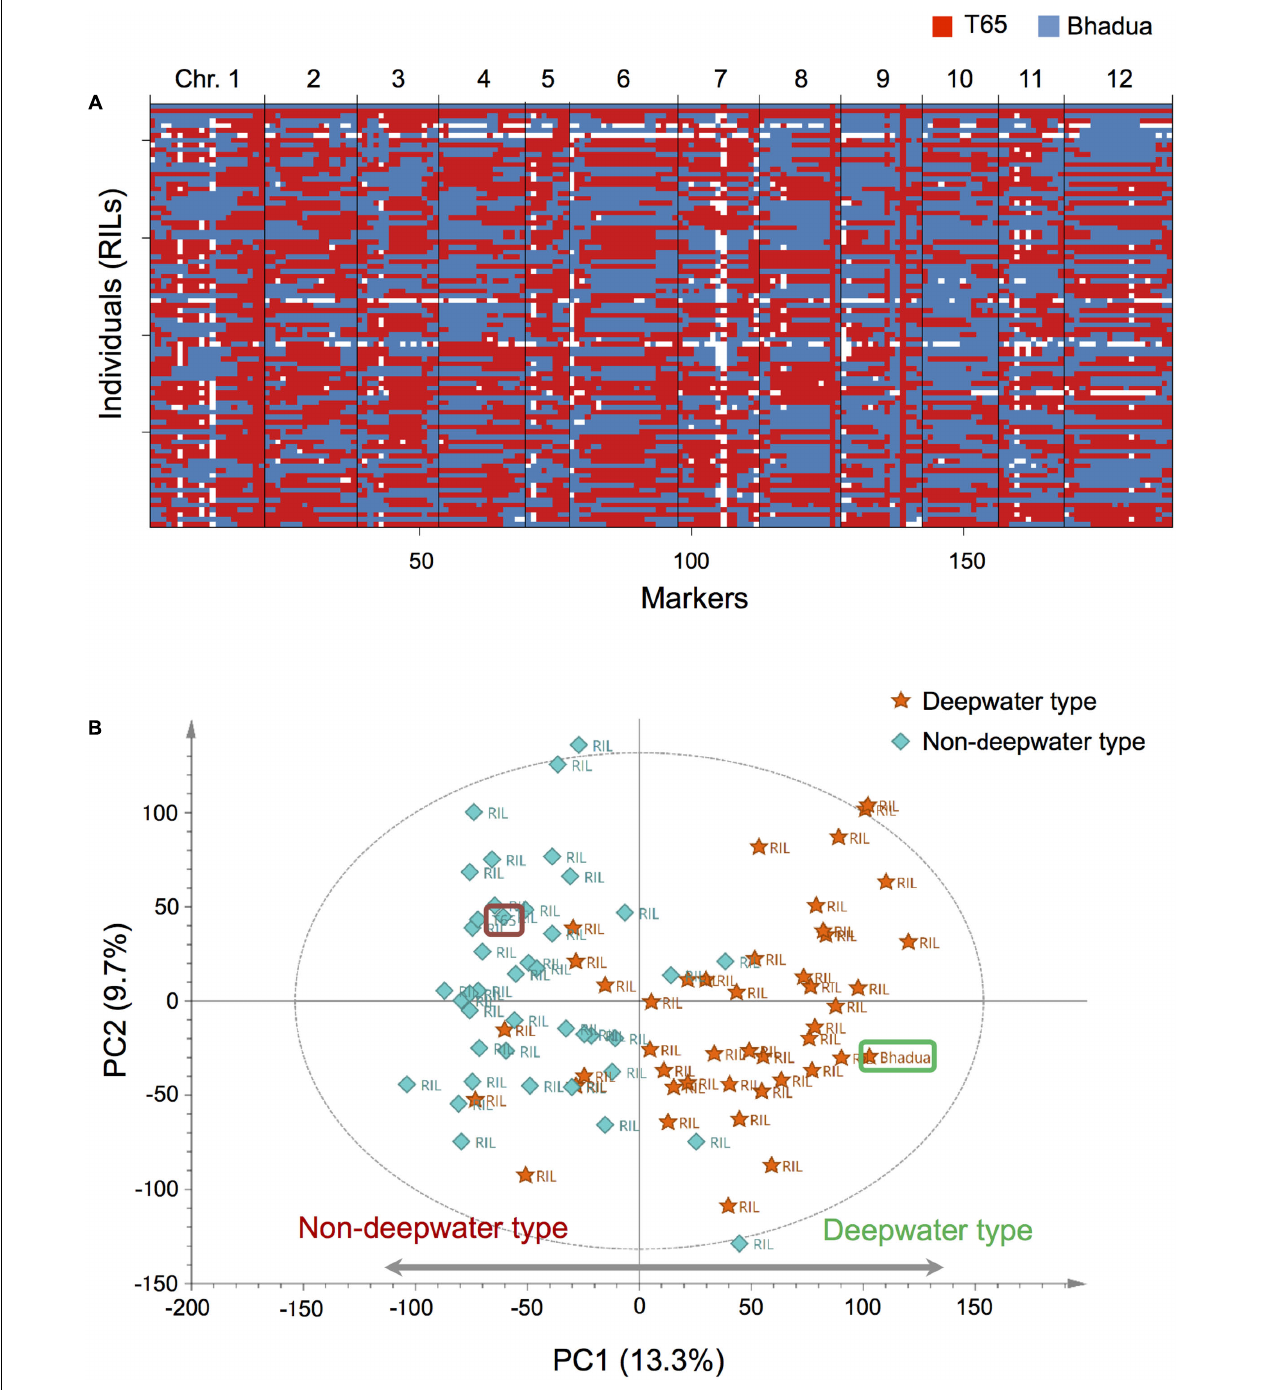
FIGURE 1 | Overview of our genetic and transcriptomic data. (A) Haplotypes of 85 recombinant inbred lines (RILs) and their parental lines, T65, and Bhadua. Each row indicates an individual plant, columns correspond to one of the bins (188 markers) arranged in physical order based on the rice chromosomes [Os-Nipponbare-Reference-IRGSP-1.0 (Sakai et al., 2013)]. Red and blue identify the T65 and the Bhadua genotype, respectively. The white box represents missing genotypes. (B) Principal component analysis (PCA) of the expression data matrix of the population. The score scatter plot reveals a clear separation between individuals; the first principal component (PC1) accounts for 13.3% of the total explained variance. Orange stars and sky blue diamonds represent RILs with deepwater phenotype (TIL ≥ 20 cm) and non-deepwater phenotype (TIL < 20 cm), respectively. Brown and green rounded squares indicate T65 and Bhadua, respectively. The ellipse indicates Hotelling’s T 2 , with 95% confidence in the score scatter plots.